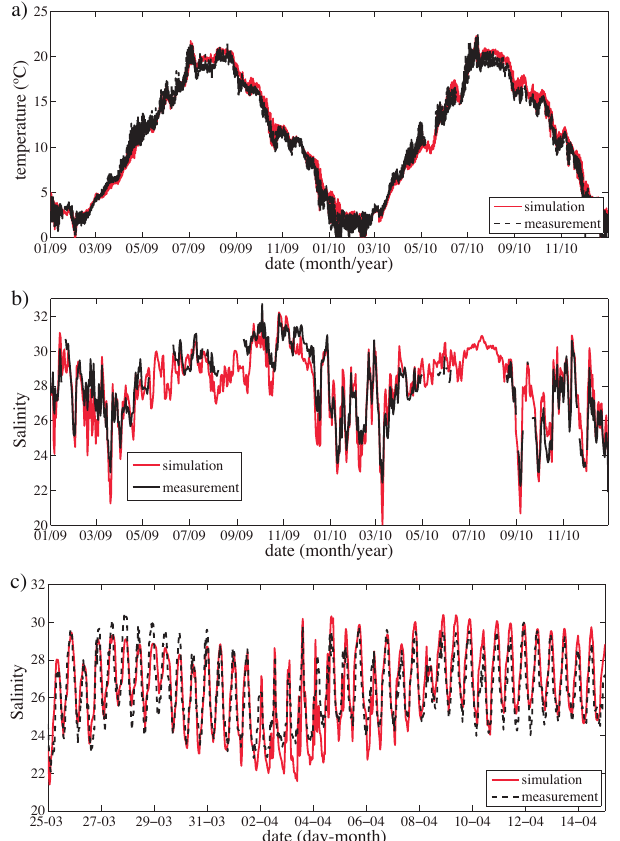
Figure 7. Comparison of temperature and salinity measurements at the NIOZ jetty station against results from the numerical simula- tions. (a) Time series of temperature with a 30min resolution for the years 2009–2010. (b) Time series daily averaged salinity for the years 2009–2010. (c) Time series of salinity with a 30min resolu- tion for the days from 25 March 2009 to 15 April 2009. Gaps in the salinity time series are due to malfunctioning of the sensor or bio- fouling. The numerical results were interpolated to a fixed depth of 1.75m below mean sea level.